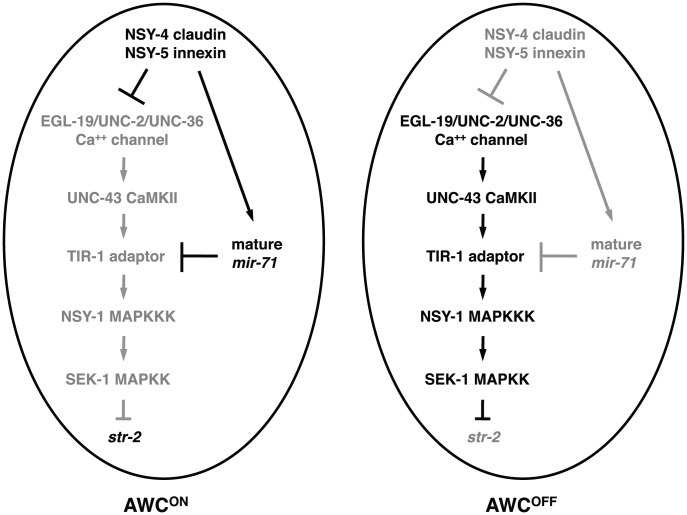
Model for mir-71 function in AWC asymmetry.In the default AWCOFF cell, tir-1 acts in a calcium-regulated kinase signaling pathway to represses the expression of the AWCON marker str-2. Both nsy-4 and nsy-5 act to increase the level of mature mir-71, which results in downregulation of tir-1 expression and subsequent de-repression of str-2 gene expression in the cell that becomes AWCON. Gray is used to indicate the gene product is less active or inactive.